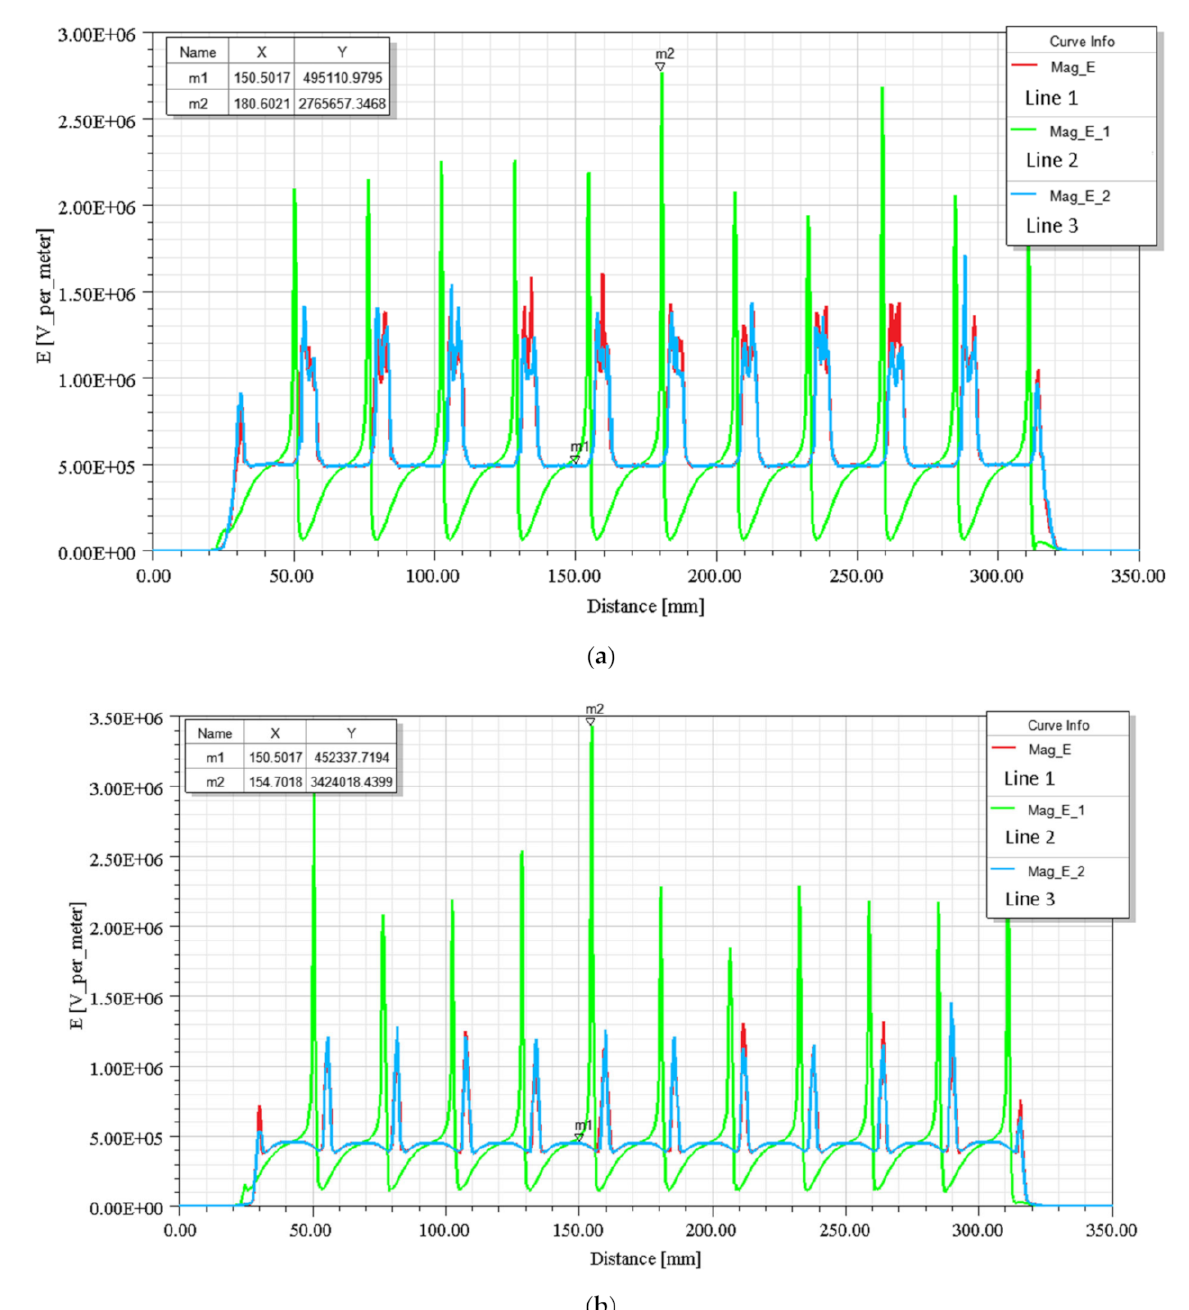
Figure 6. Electric field along the main axis of the panel: ( a ) model M3; ( b ) model M4. The curved (sine) geometry of the M3 electrode results in a varying distribution of the electric field across the plate, and this is shown by the three lines of Figure 6a, where line 1 and line 3 pass through the “top” and “bottom” of the curve, and line 2 passes through the “zero point” of the curve. Likewise the triangular geometry of the M4 electrode results in a varying distribution of the electric field across the plate, and this is shown by the three lines of Figure 6b, where line 1 and line 3 pass through the “top” and “bottom” vertices of the line and line 2 passes through the “zero point” of the line. The ratio between the maximum and minimum values of the electric field of M4 was found to be